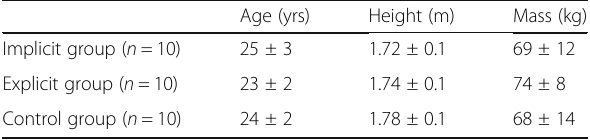
Table 1 Participants ’ demographics (age, height, mass: mean ± standard